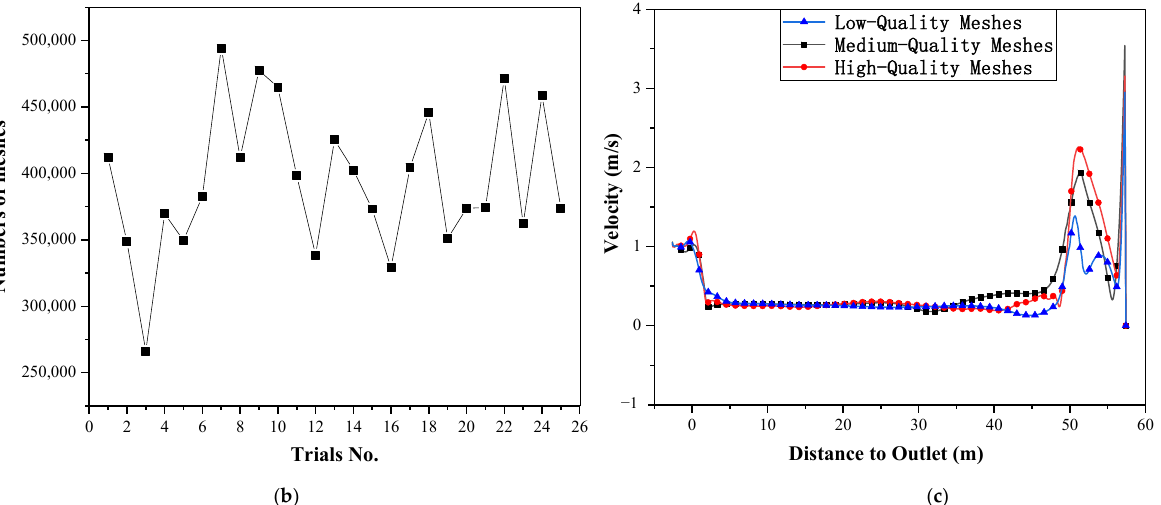
Figure 3. ( a ) Meshes of the 3D simulation model; ( b ) numbers of meshes for each trial; ( c ) independent verification test results of the meshes: comparison of flow velocity line graphs for different quality meshes (the flow velocity on the centerline of 1.5 m height from the floor was compared).